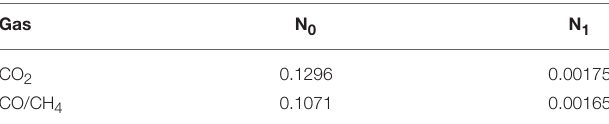
TABLE 2 | Noise model coefficients used to calculate SNR and the resultant uncertainties for each retrieved